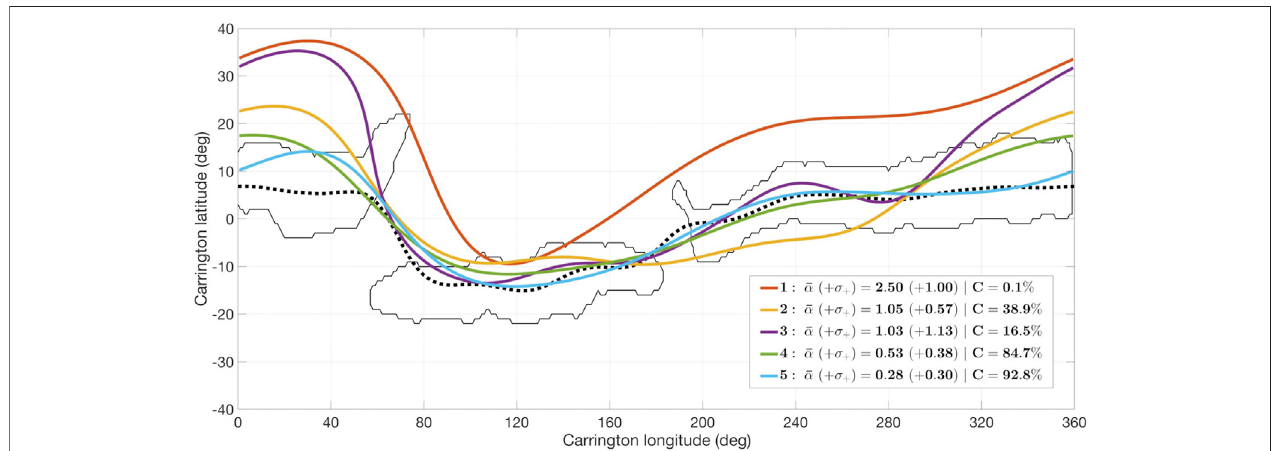
FIGURE 3 | Comparison of several NLs against the SMB line and SB contour identi fi ed in Figure 2 . NLs computed from the PFSS model using different R ss and magnetograms on the 03 – 10-2020 12:00 from: 1) GONG/mrbqs (R ss : 3 . 0 R ⊙ ); 2) GONG/ADAPT 7th realization (R ss : 2 . 5 R ⊙ ); 3) GONG/ADAPT 10th realization (R ss :